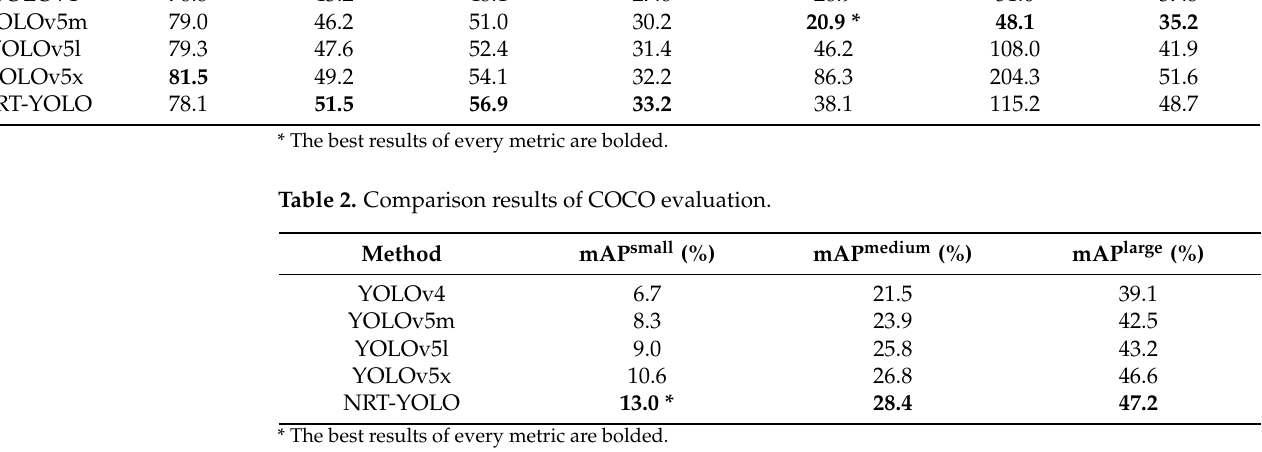
Table 3. Comparison results (mAP 0.5 ) of different classifications between NRT-YOLO and other YOLO methods.